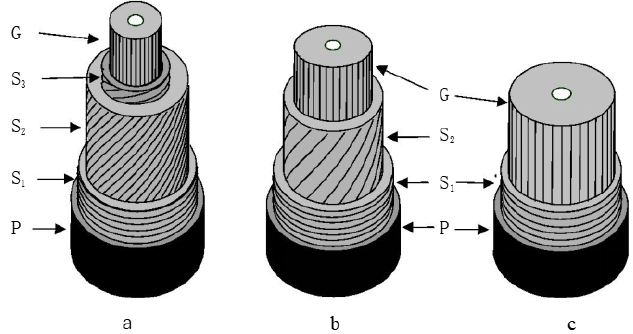
Figure 3. Cell wall structure of three types of gelatinous fibers: ( a ) a G-layer in addition to the three layers of the normal secondary cell wall; ( b ) a G-layer that replaces the S 3 layer; ( c ) a G-layer that replaces both the S 2 and S 3 layers. P: primary wall; S 1 : outer layer of the secondary wall; S 2 : middle layer of the secondary wall; S 3 : inner layer of the secondary wall; G: gelatinous layer.